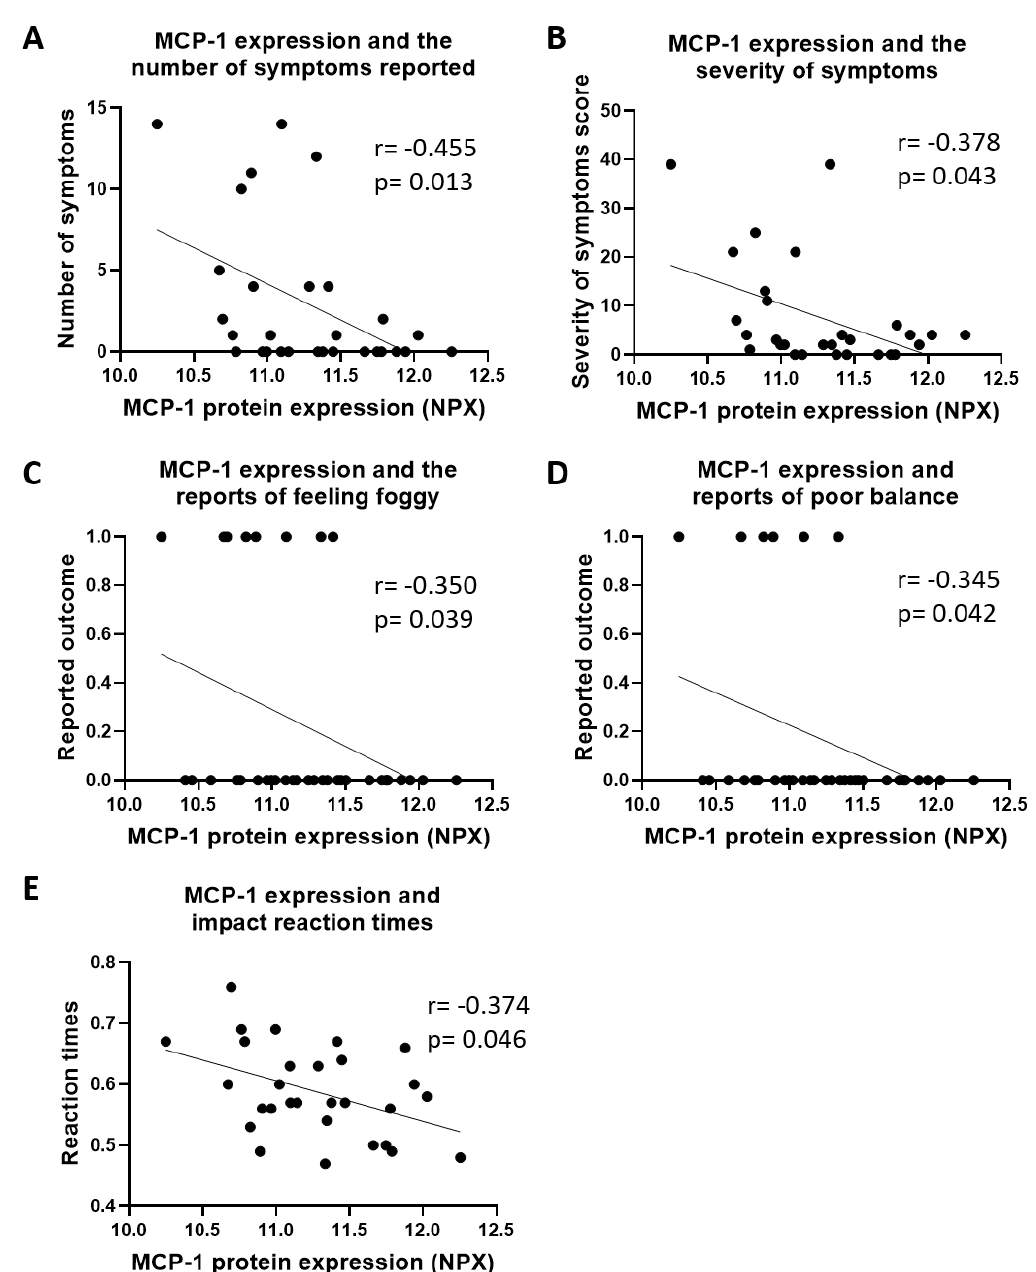
Figure 5. Macrophage chemotactic protein-1 (MCP-1) protein expression correlated to clinical data. Reduced MCP-1 expression was associated with increases in the number of ( A ) reported symptoms and their ( B ) severity. This included feeling ( C ) foggy and reports of ( D ) poor balance. There was also a significant negative correlation between MCP-1 expression and ( E ) reaction times. Data was analyzed according to Spearman’s correlation coefficient where the number of pairs = 29 and p < 0.05. Reduced serum levels of MCP-1 were also related to an increase in the number (Figure 5A; r = 0.455, p = 0.013) and severity of symptoms (Figure 5B; r = − 0.378, p = 0.043) reported. Low levels of MCP-1 were correlated with greater numbers of patients feeling foggy (Figure 5C; r = − 0.350, p = 0.039) and having poor balance (Figure 5D; r = − 0.345, p = 0.042). Additionally, reduced serum MCP-1